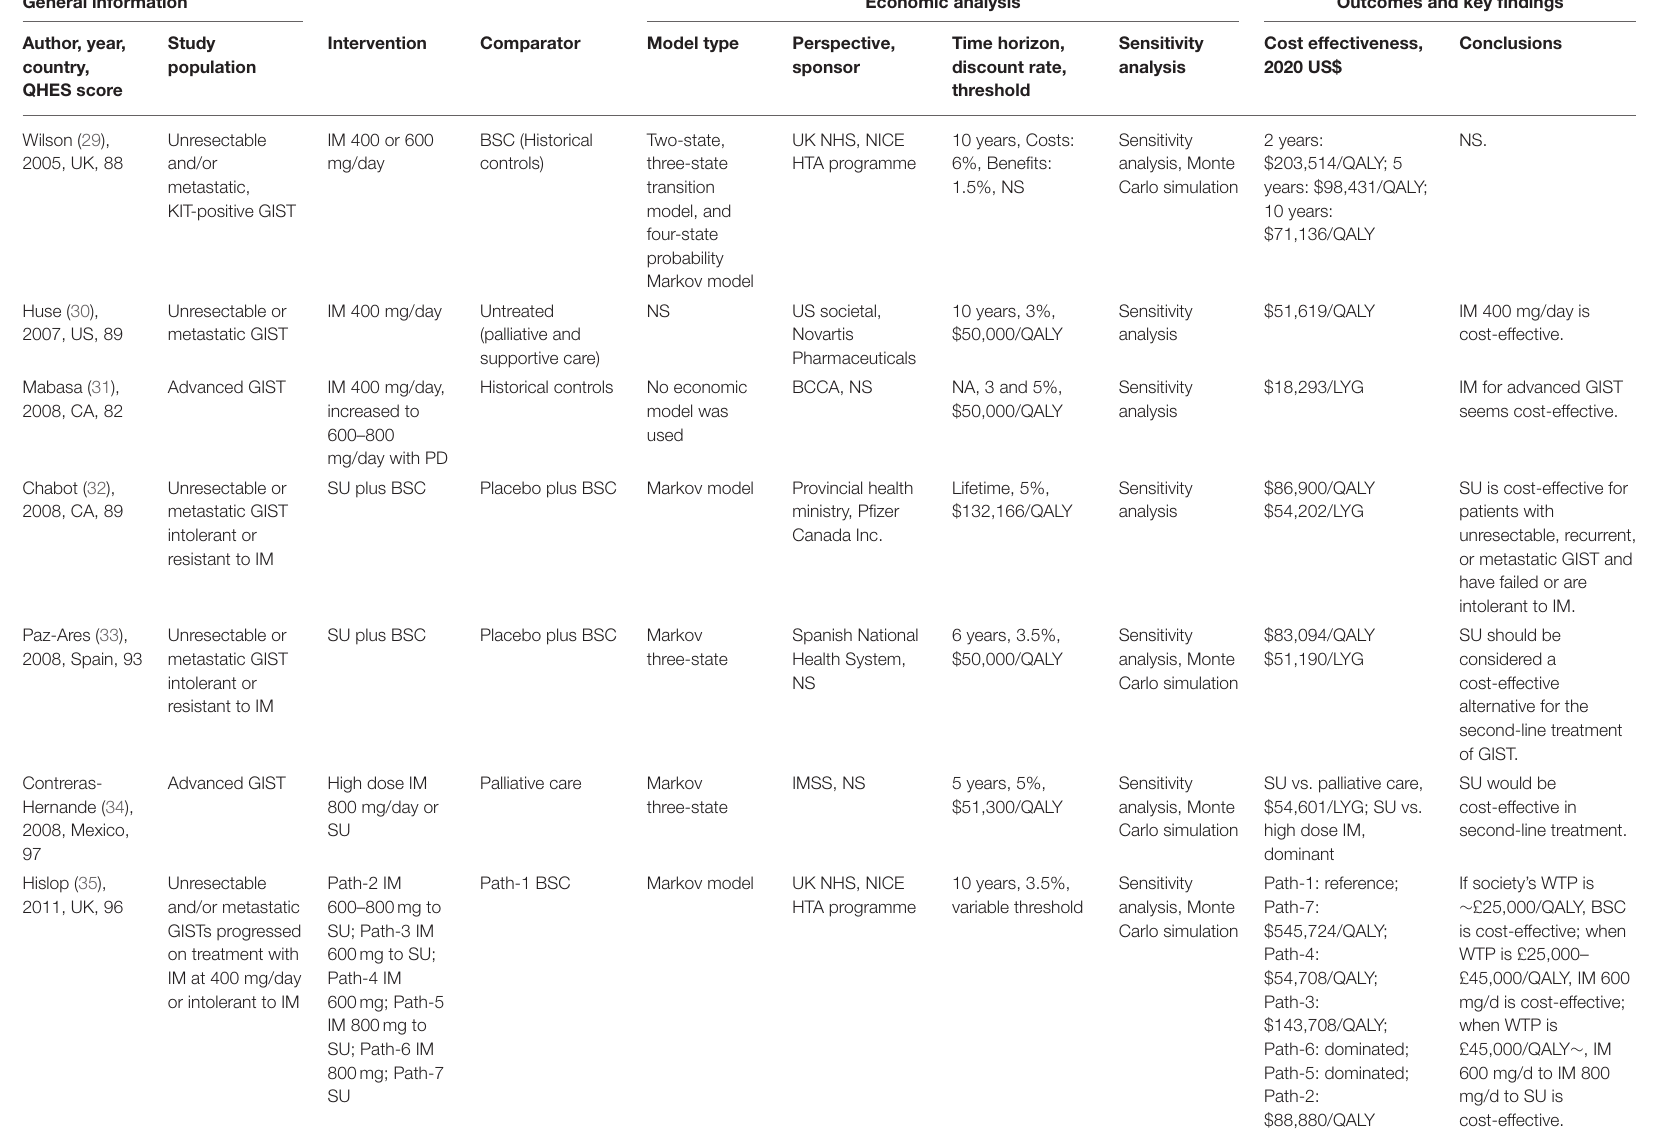
TABLE 1 | Summary of included economic evaluations for advanced